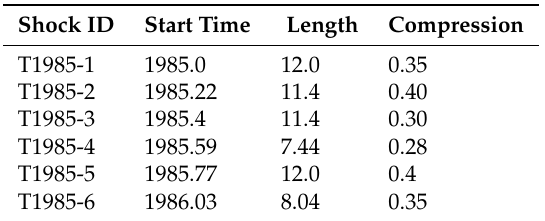
Table A1. Shock attributes for T1985.